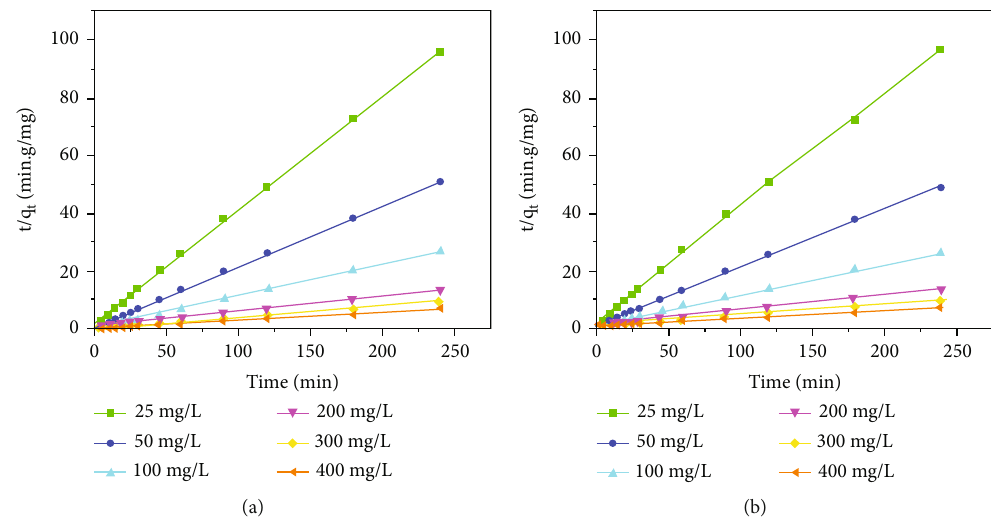
Figure 10: Plot of pseudosecond-order model for (a) JPAC adsorption and (b) JPAC/TiO Table 5: Adsorption isotherm parameters of JPAC and JPAC/TiO